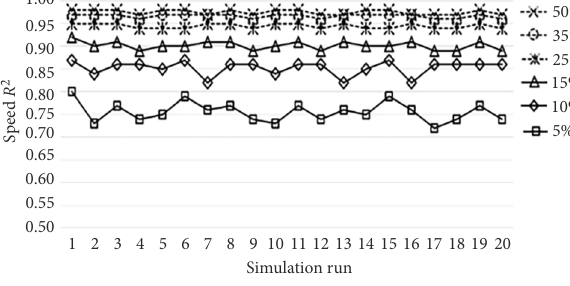
4. Variation of R 2 performance of MC